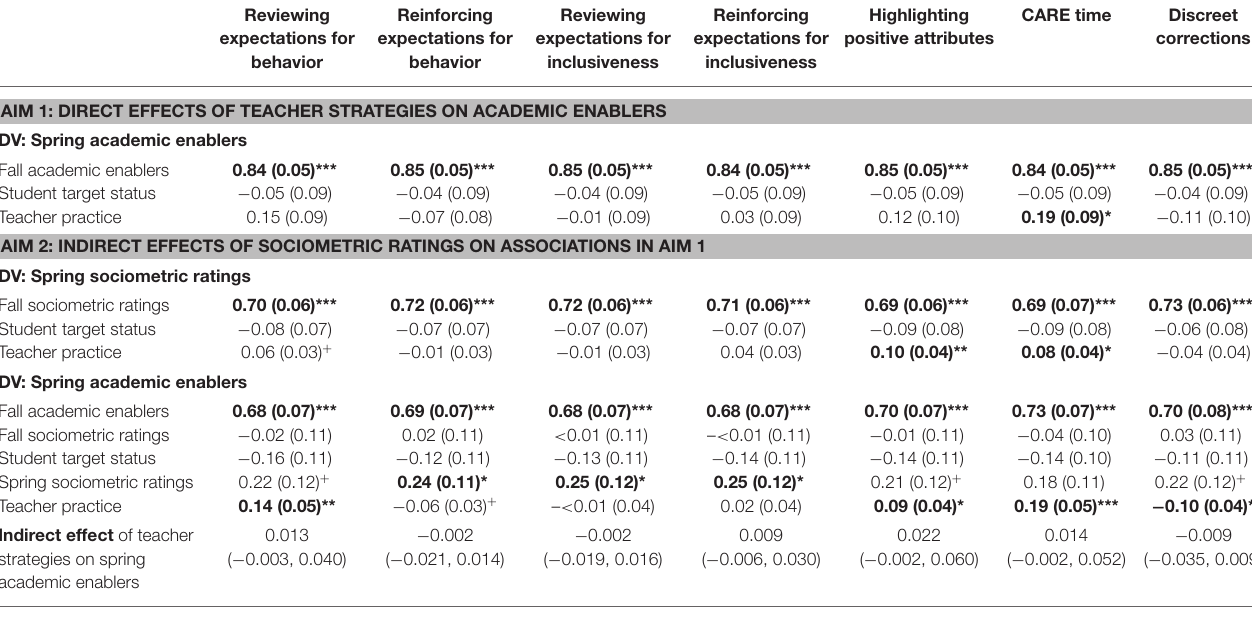
TABLE 3 | Summary of analyses for Aims 1 and